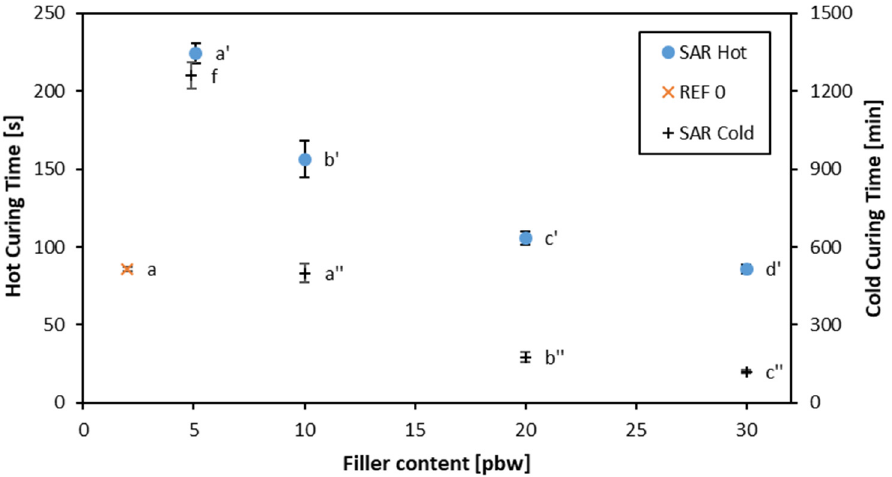
Figure 2. The dependence of the curing time vs. filler content (the letters on the plots indicate the homogeneous